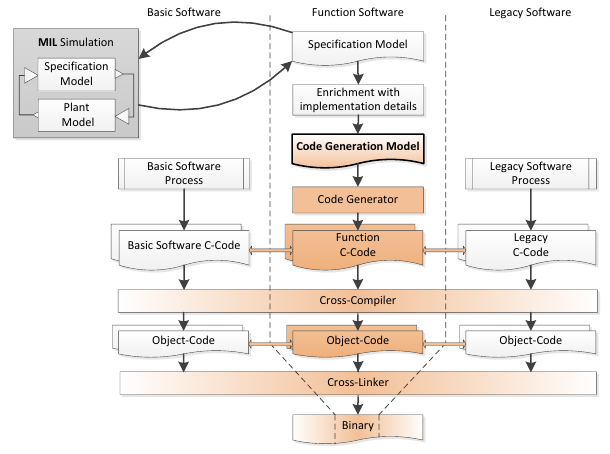
Figure 1: The generic build process for a model- based development toolchain with an auto- matic code generator (adapted from Schnei- der et al.